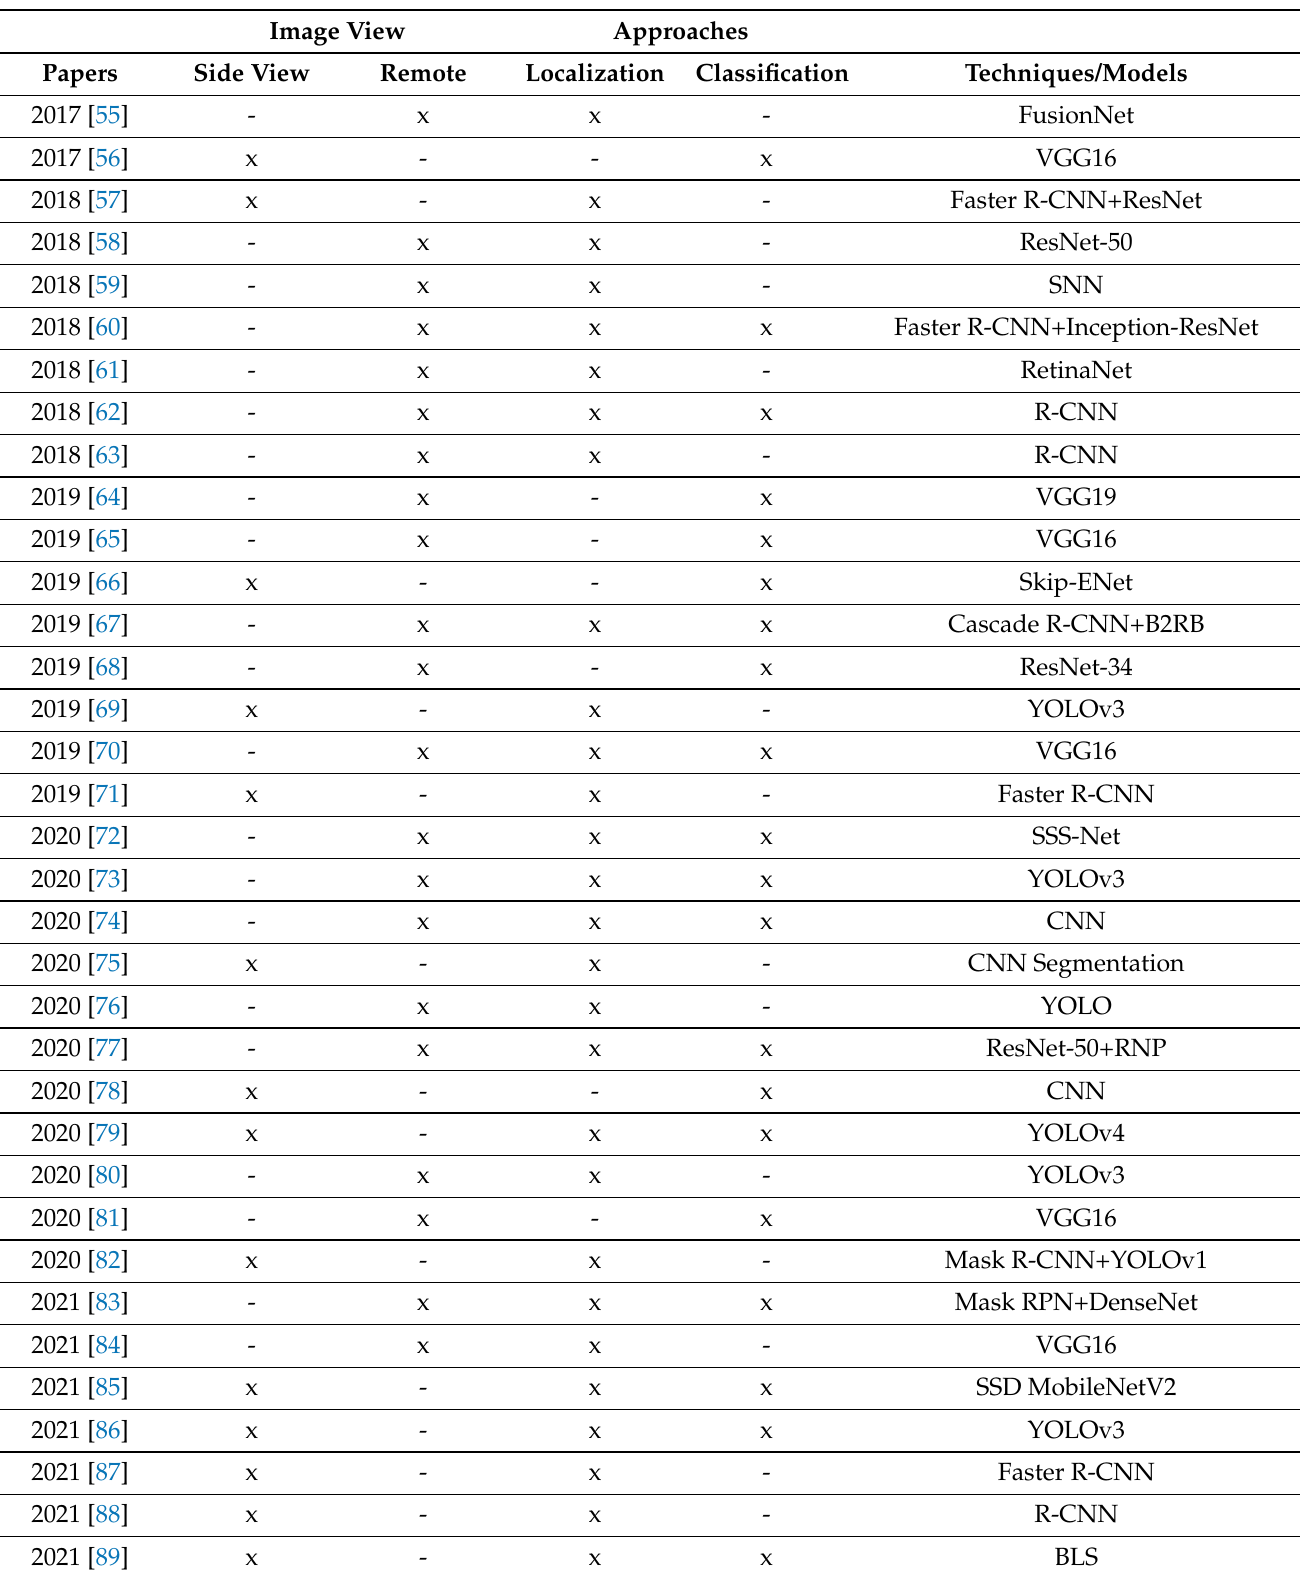
Table 1. Models and features on related